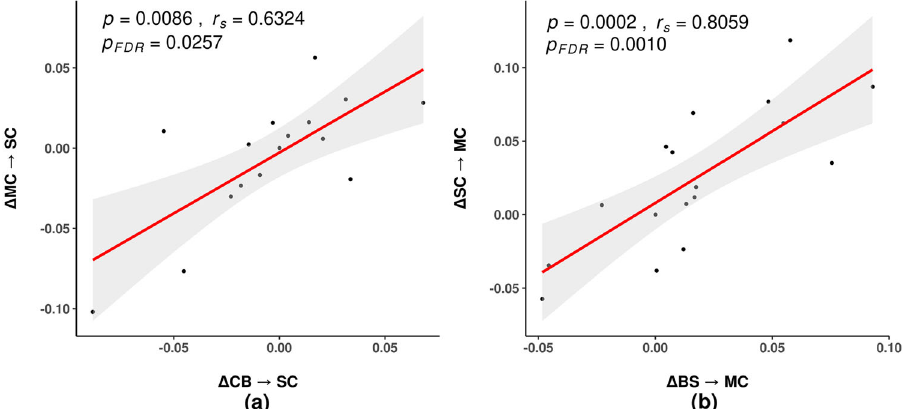
Fig. 4 Correlation between Δ EC in PD patients. Δ EC indicates the difference of the EC connectivity before and after TT. a Δ EC correlation between CB ⇀ SC and MC ⇀ SC . b Δ EC correlation between BS ⇀ MC and SC ⇀ MC . BS brainstem, CB cerebellum, MC motor cortex, SC subcortical region, TT treadmill training, EC effective connectivity, Δ difference of EC in the patients at baseline and follow-up, FDR false discovery rate.